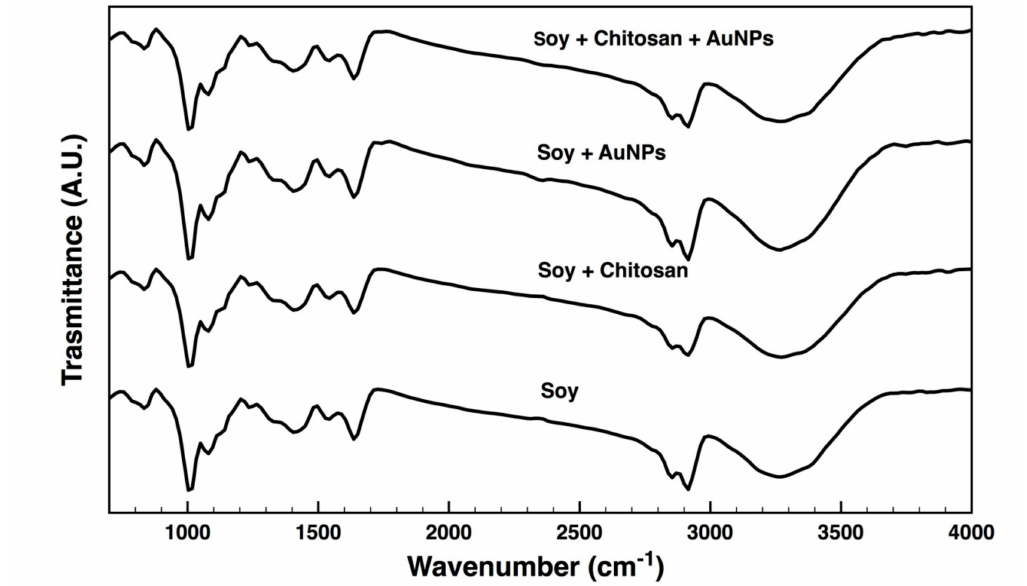
Figure 4. Attenuated Total Reflectance-Fourier-Transform Infrared Spectroscopy (ATR-FTIR) spectra of soy fabrics untreated, treated with 20% chitosan, functionalized with AuNPs, and treated with 20% chitosan and subsequently functionalized with AuNPs (4000–700 cm − 1